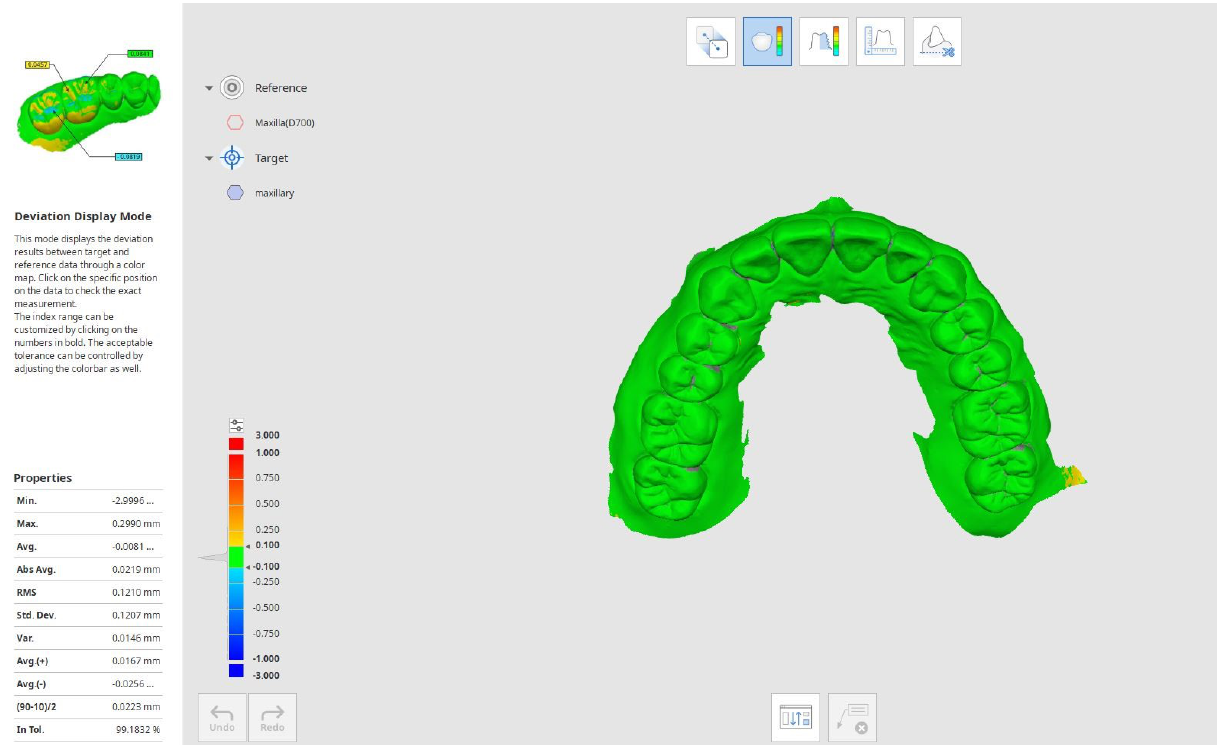
Figure 6. Medit Compare automatically calculates and shows in a column the deviations between the reference scan made with a lab scan and the target one made with an IOS scan.